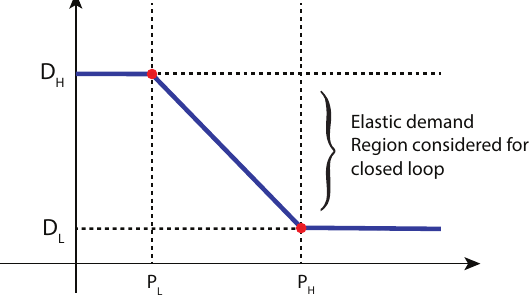
Figure 7. Parameters for demand elasticity function.